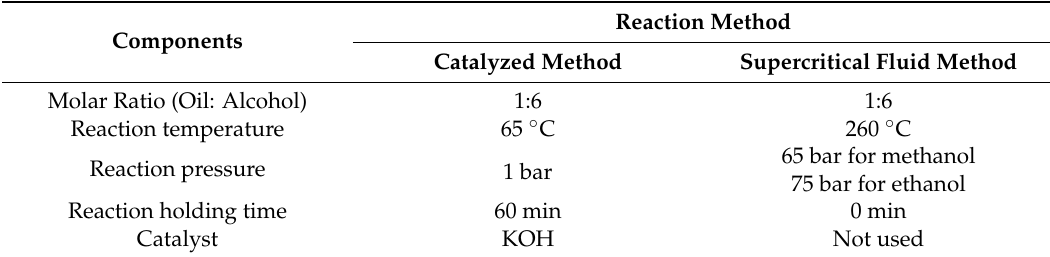
Table 1. Experimental conditions used in this